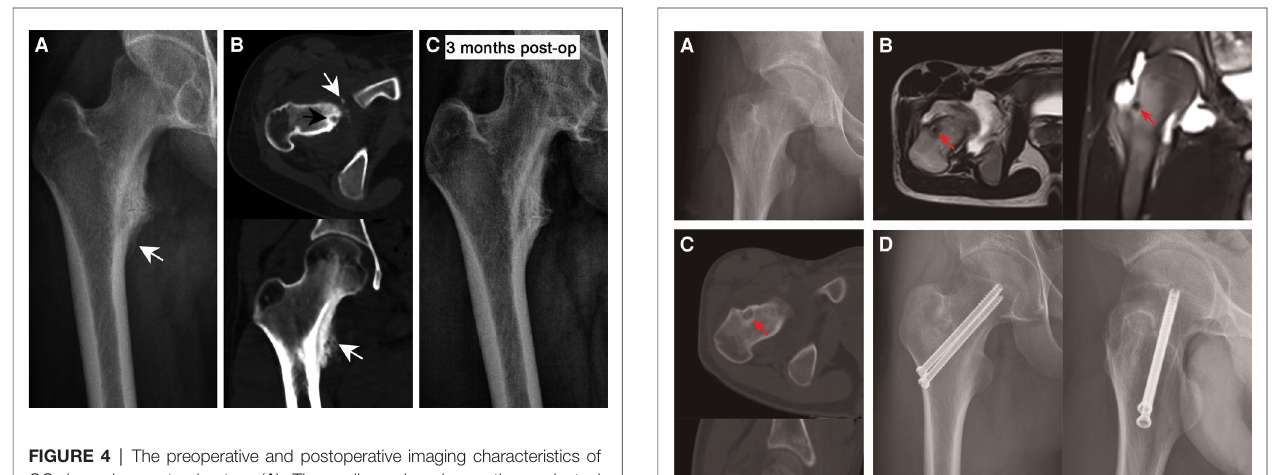
FIGURE 4 | The preoperative and postoperative imaging characteristics of OO in a lesser trochanter. ( A ) The radiography shows the periosteal reaction caused by the nidus but the nidus is not visible. ( B ) Thin-layer CT accurately displays the nidus and the surrounding hyperplastic bone. ( C ) Postoperative radiographs show that the reaction bone was completely absorbed and the bone morphology was restored to normal (The white arrow shows the nidus, black arrows indicate reactive hyperplastic bone).